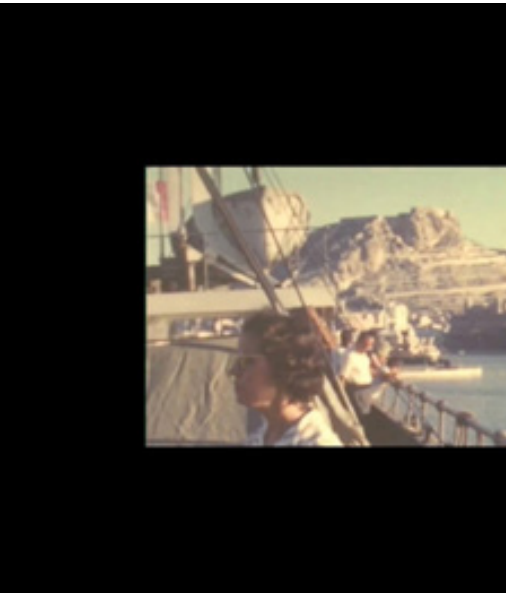
Fig. 2 Screenshot from Let’s Reset the Clock, 2’37” colour